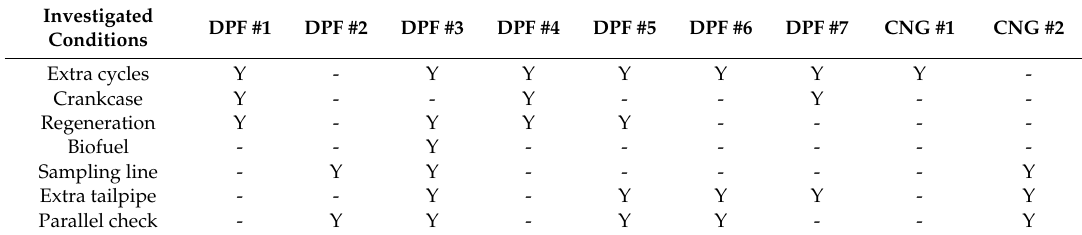
Table 1. Test protocol. Y =